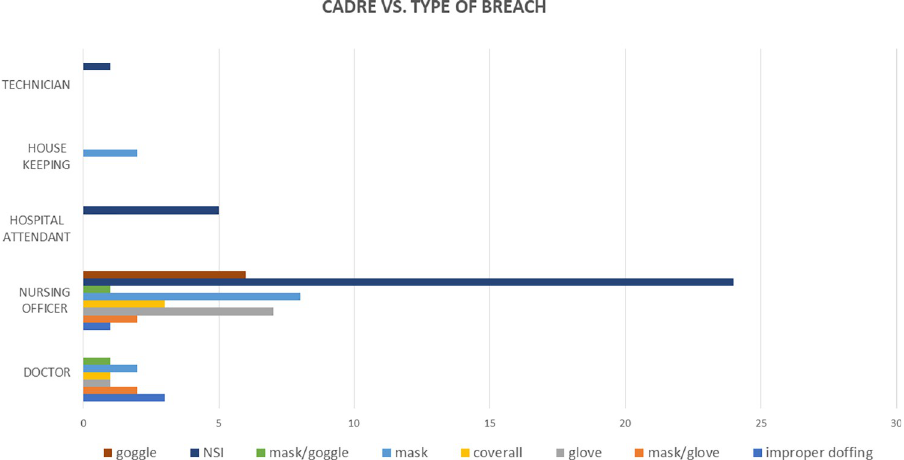
PLOS ONE | https://doi.org/10.1371/journal.pone.0268582 May 17,